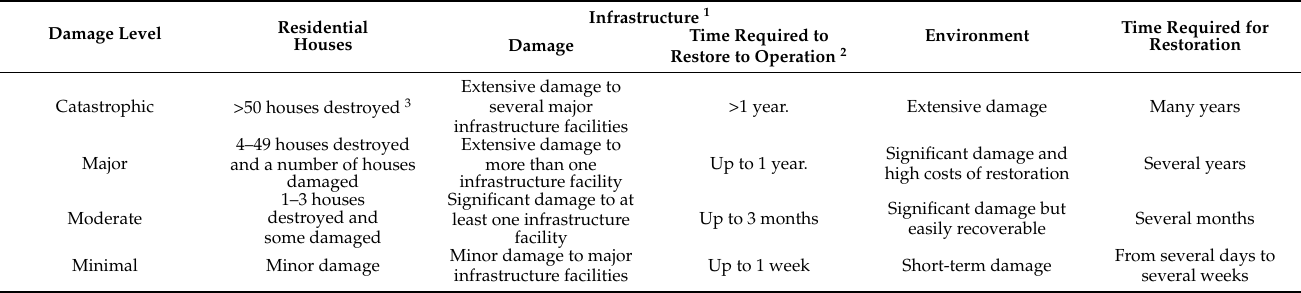
Table 3. Determination of assessed damage levels by [30] is licensed under CC BY